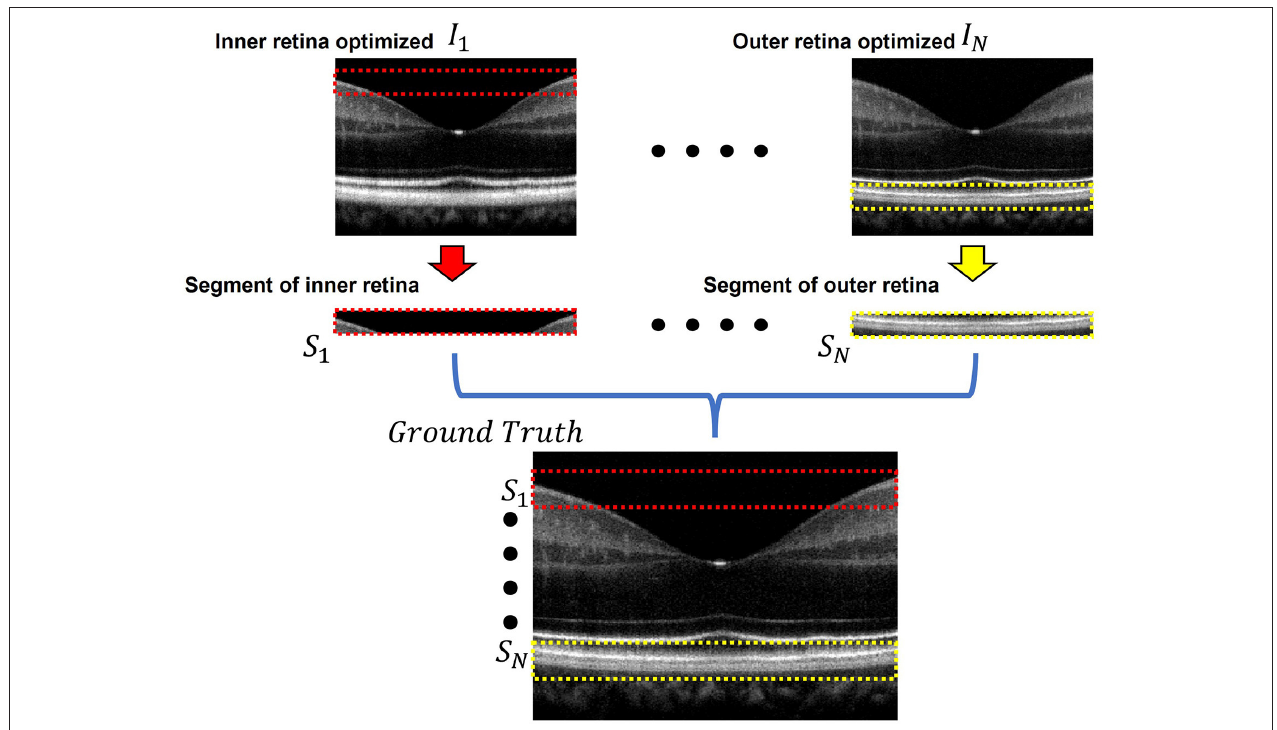
FIGURE 2 | Ground truth preparation. An array of images ranging from I 1 to I N were utilized to prepare the ground truth image. Each image was compensated by a single second order co-efficient ranging from C 1 to C N . Well compensated layers from each image were extracted and stitched together to form the ground truth image. In I 1 the inner retinal segment (demarcated by the dashed red box) is better compensated compared to the inner retinal segment in I N . On the other hand, the outer retinal segment in I N (demarcated by the dashed yellow box) is better compensated compared to that of I 1 . The ground truth was prepared by stitching the inner retinal segment S 1 from I 1 and outer retinal segment S N from I N . The adjacent layers were similarly extracted and stitched from the subsequent images between I 1 and I N